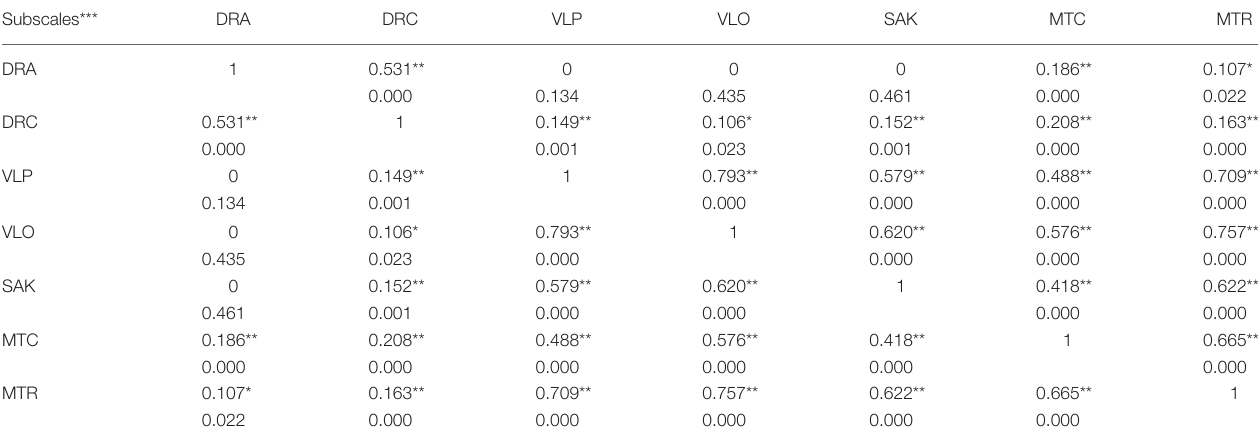
TABLE 3 | Intercorrelation relationships between the subscales of experiences of destructive relationships at work and motives for seeking spiritual assistance in religious organizations ( N = 463).